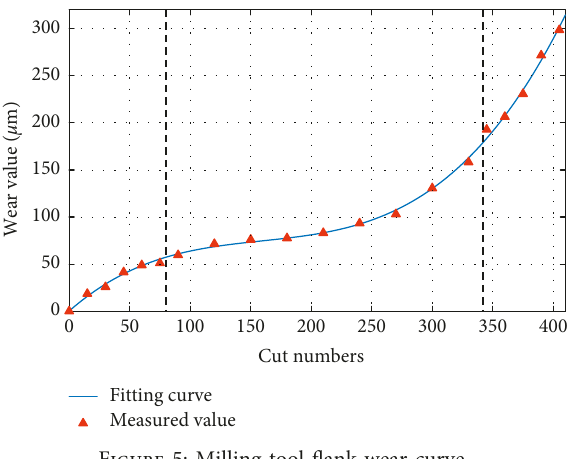
Figure 5: Milling tool flank wear curve. Table 4: Tool wear categories and wear